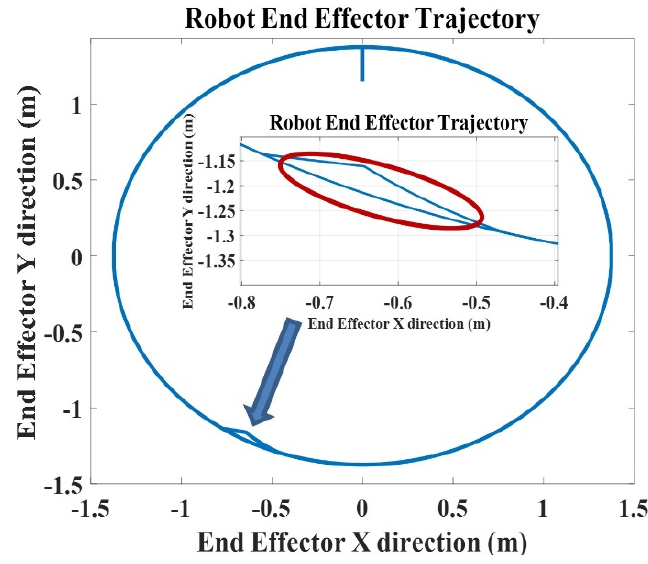
Figure 18. Sharp-turn corner obstacle avoidance trajectory (end-effector) .